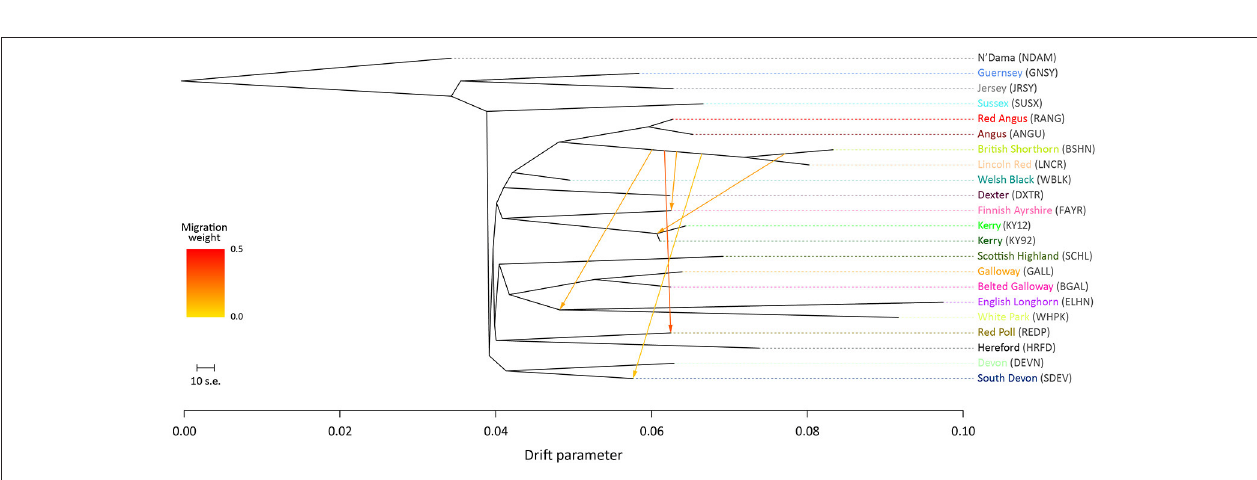
Frontiers in Genetics |